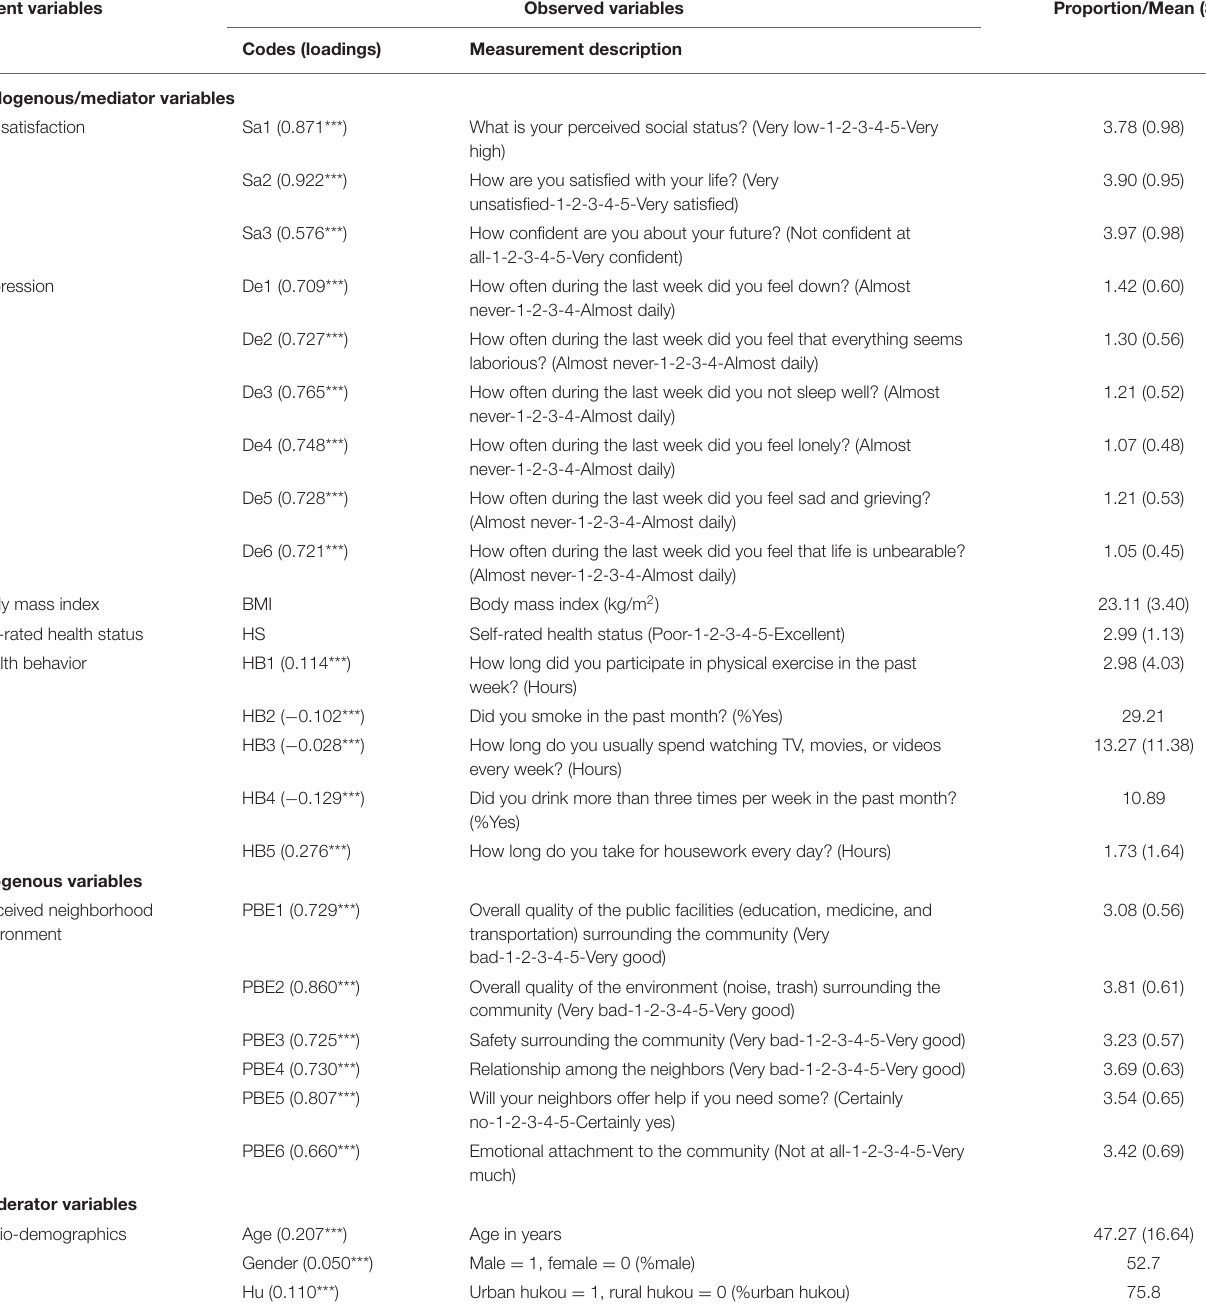
TABLE 2 | Summary statistics of all the